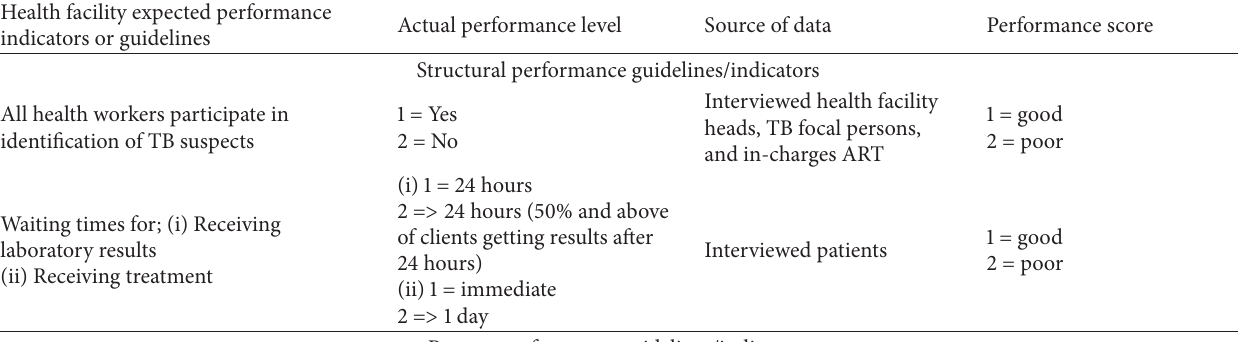
Table 1: Performance indicators/guidelines against which quality for Kamuli district health facilities was